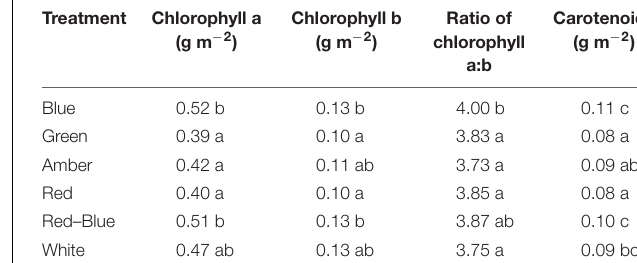
TABLE 3 | Effects of spectral composition on the light on chlorophyll contents.